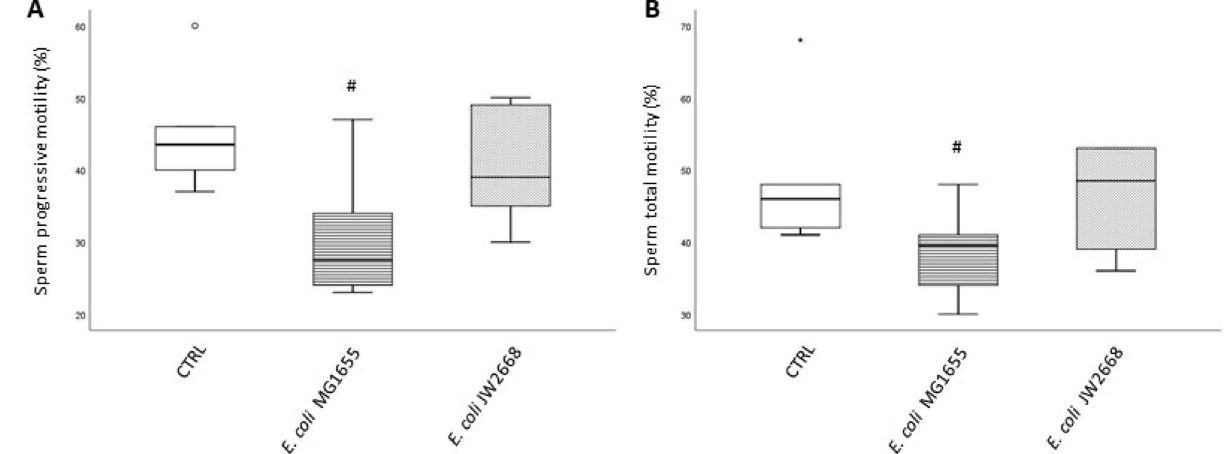
Figure 2. Box-plots representing the effect of 3 h in vitro incubation (37 °C, 5%CO 2 ) of whole semen samples (n = 6) with E. coli MG1655 (wild-type strain) and E. coli JW2668 (knockout for SIF) on sperm progressive (A) and total (B) motility. Wilcoxon test, *p < 0.05; #p < 0.01 versus CTRL.